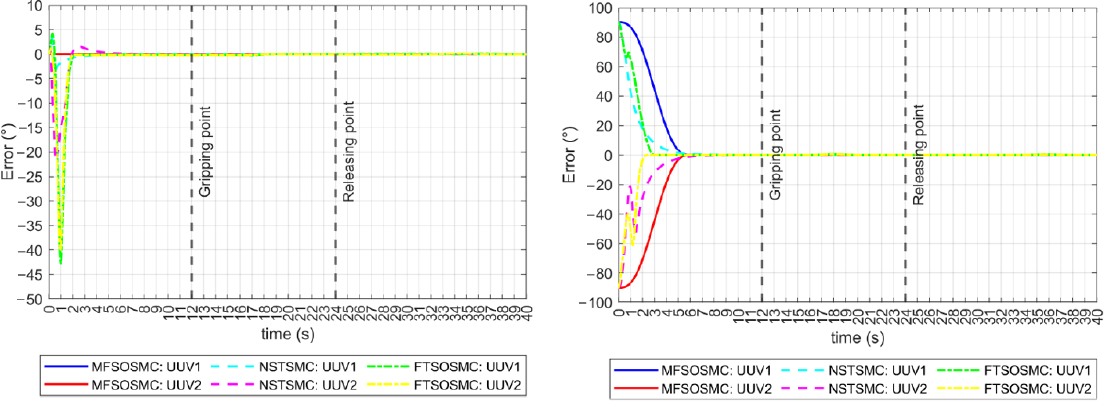
Figure 11. Tracking error for all the controllers (no external disturbances). Left : 𝜙 orientation. Right : 𝜓 orientation.